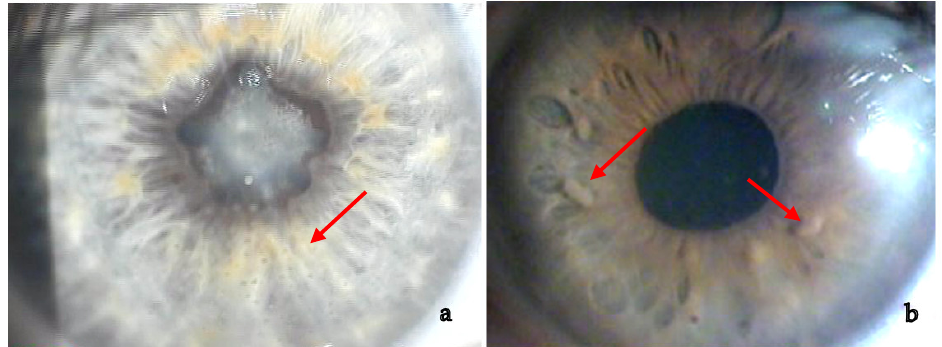
Figure 2. ( a ) Granulomatous anterior uveitis with large keratic endothelial precipitates mainly spread in the inferior part of the cornea. ( b ) Busacca iris nodules.